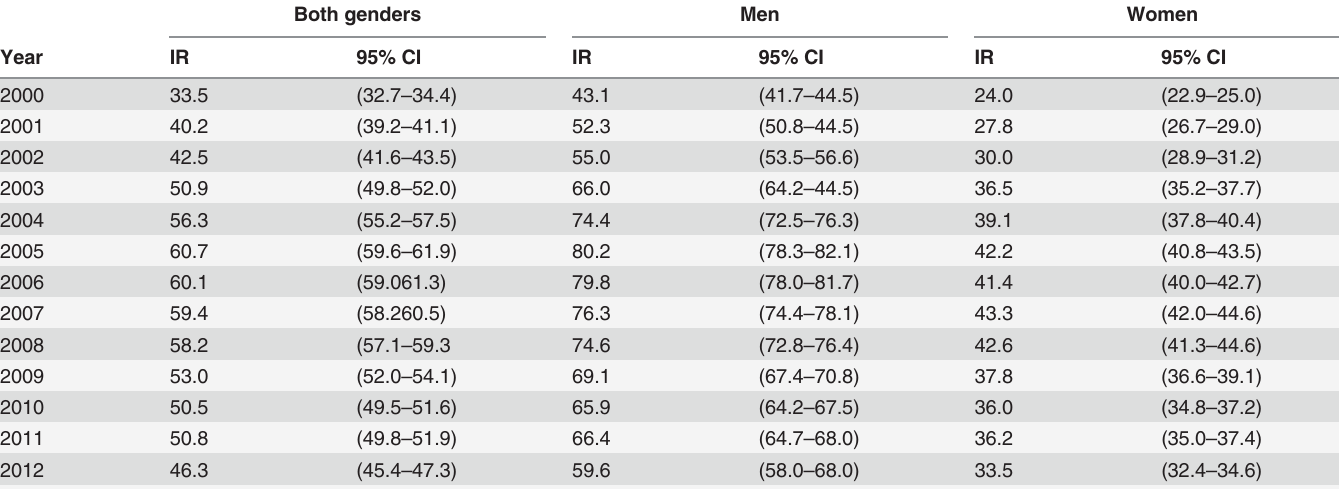
Table 1. The secular trend in the OHCA incidence rate in Taiwan (the number of cases per 100,000 persons), for national data of Taiwan from 2000 to 2012, by gender. Both genders